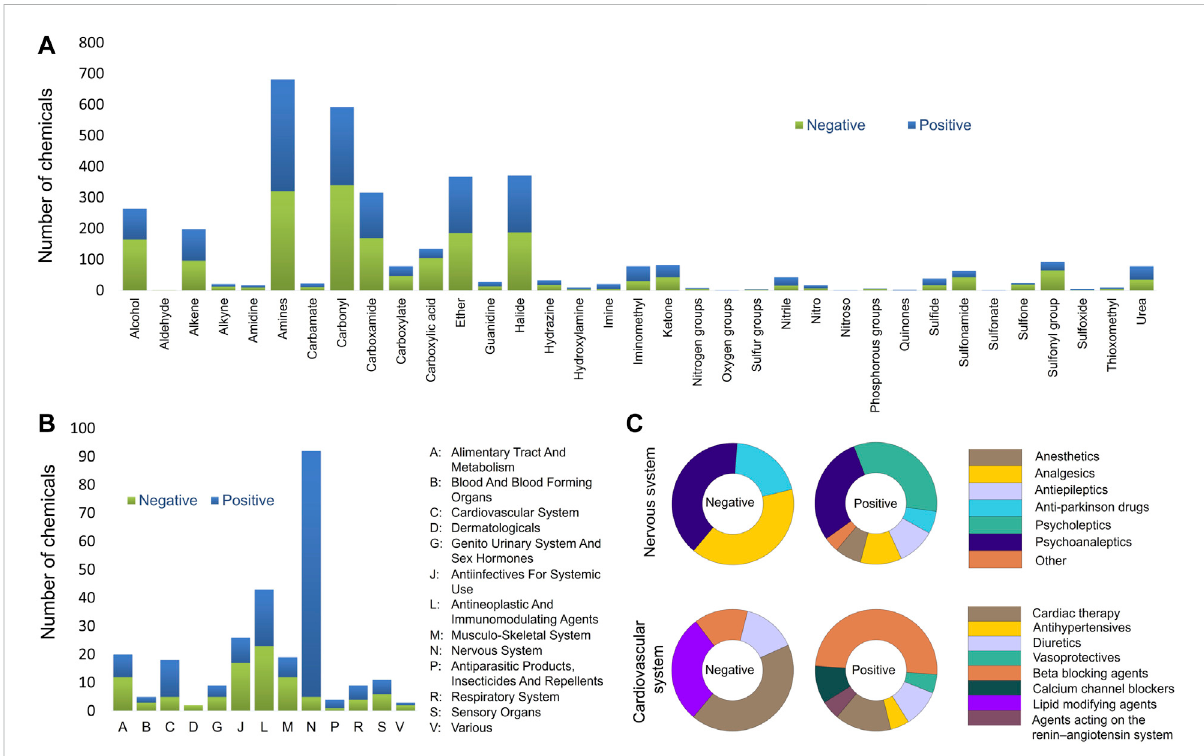
FIGURE 1 Database analysis (A) Assessment of thefunctional groups presentin the entire BBB database. (B) Anatomical Therapeutic Chemical (ATC) level 1 classes present BBB database. (C) ACT level 2 classes of the nervous and cardiovascular